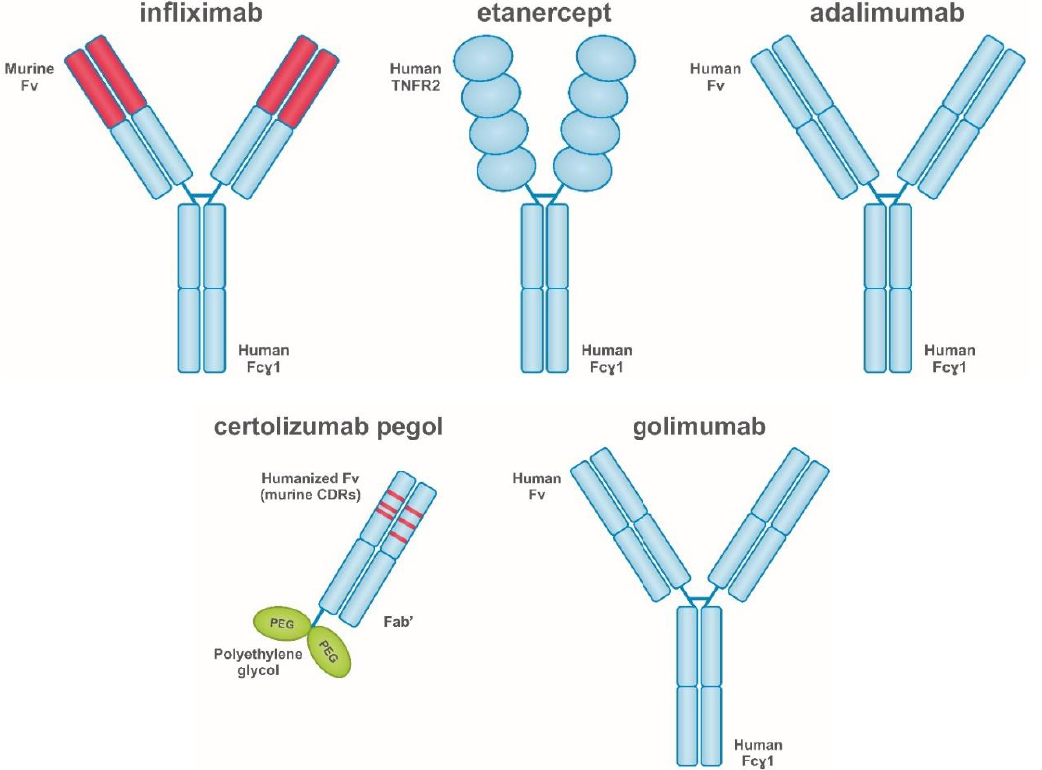
Figure 1. Structure and nomenclature of tumor necrosis factor-alpha (TNF-α) inhibitors.